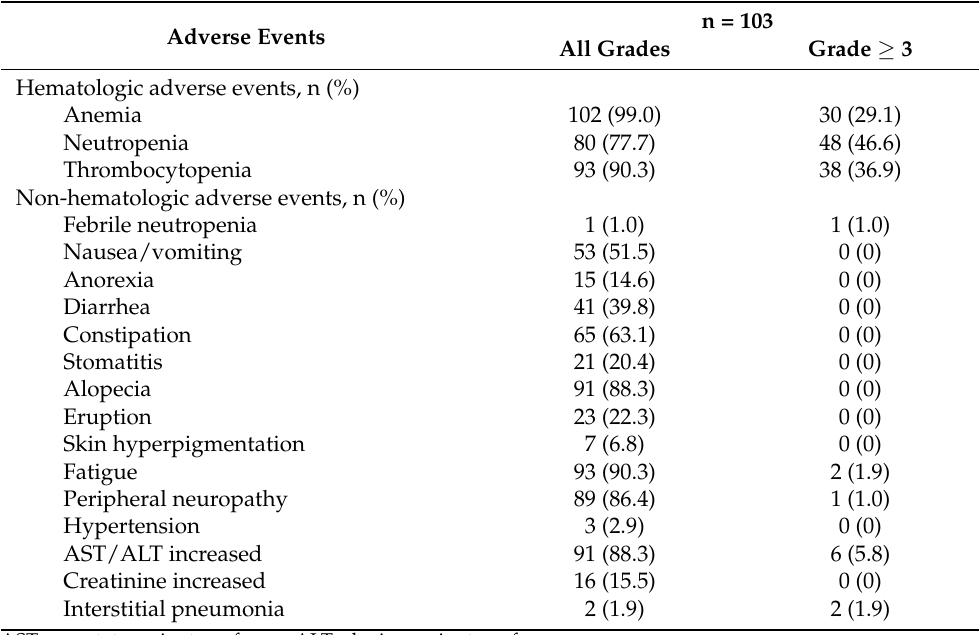
Table 5. Adverse events of gemcitabine plus nab-paclitaxel.